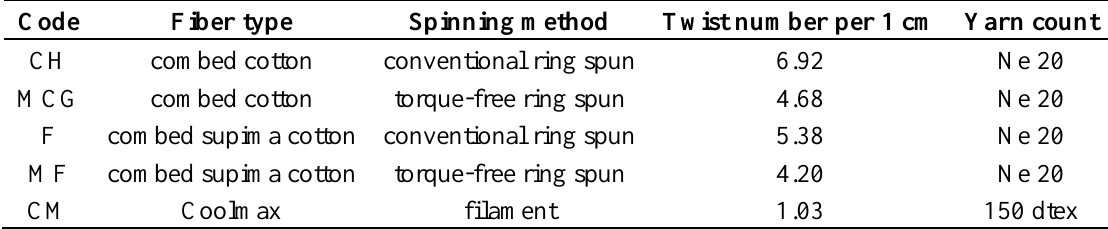
Table 1. Yarn specification